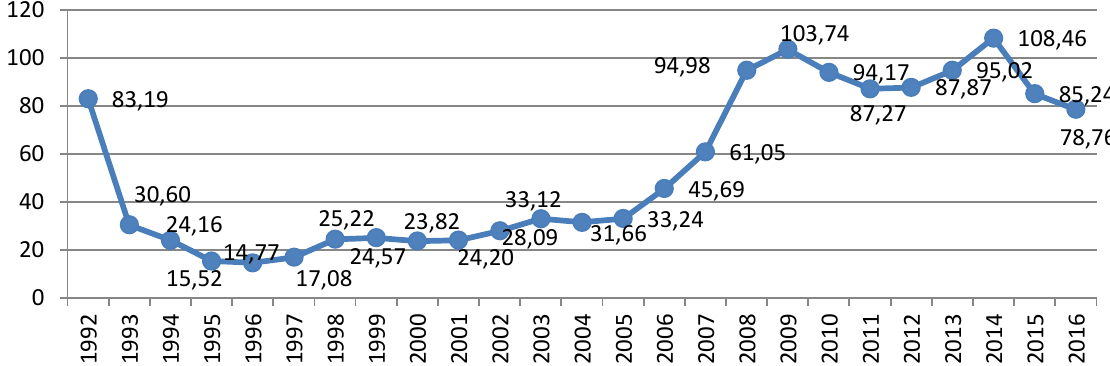
Source: National Bank of Ukraine; World Bank,